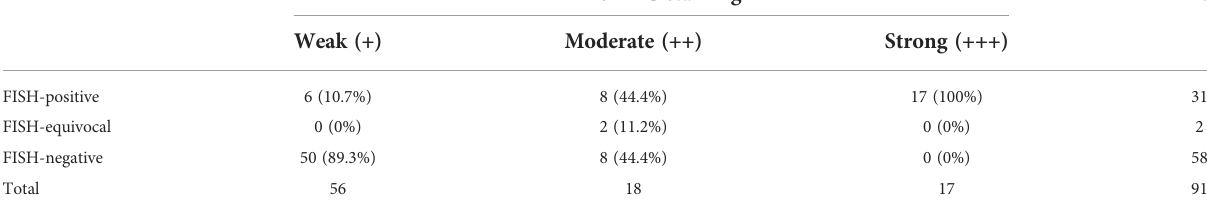
TABLE 2 Correlation of IHC and